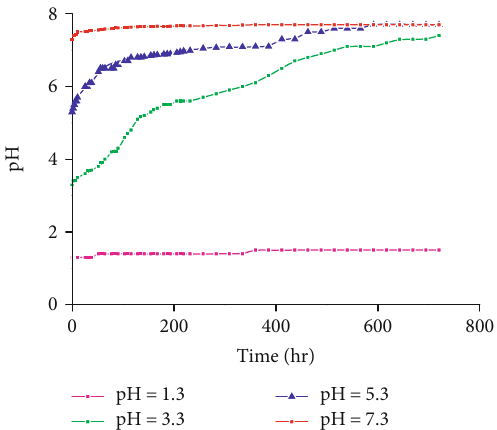
Figure 1: pH value of solution with time.